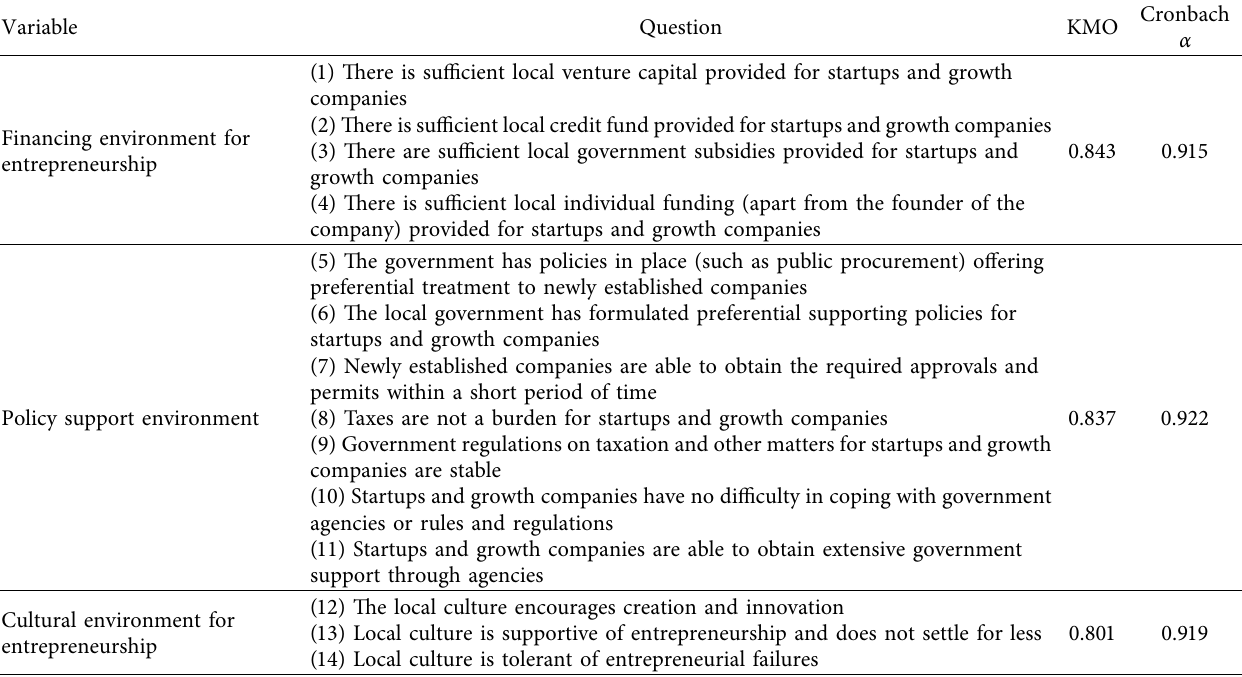
Table 1: Reliability and validity of scales for satisfaction toward the entrepreneurial environment.